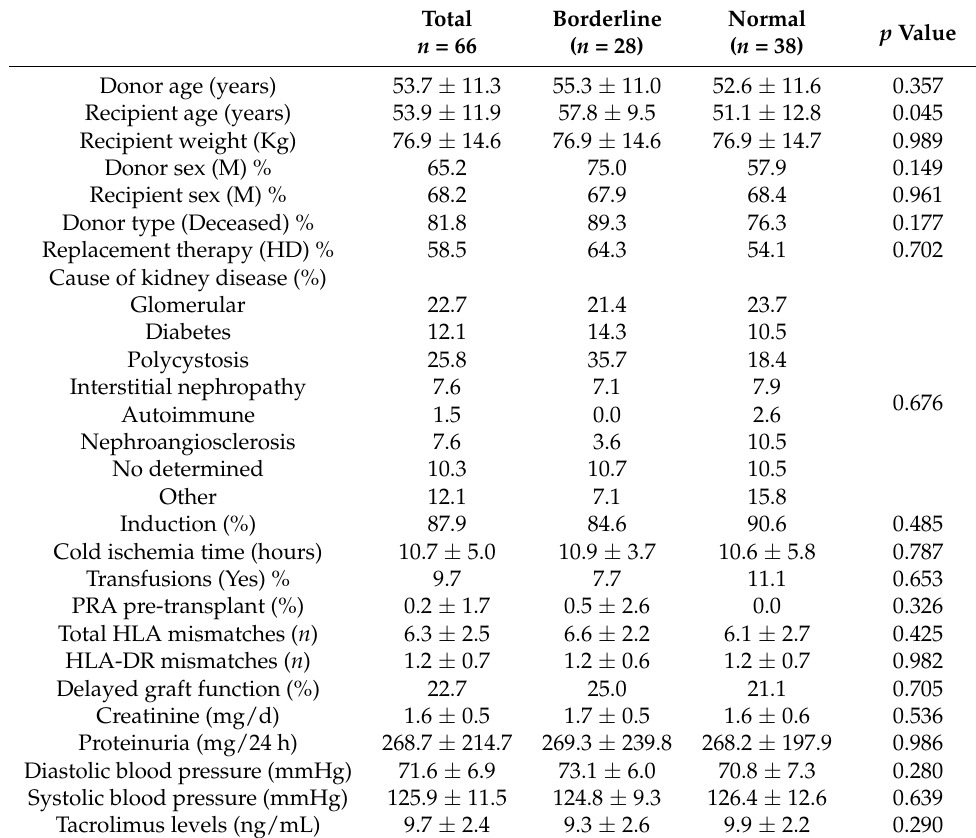
Table 1. Clinical and demographic characteristics of the study